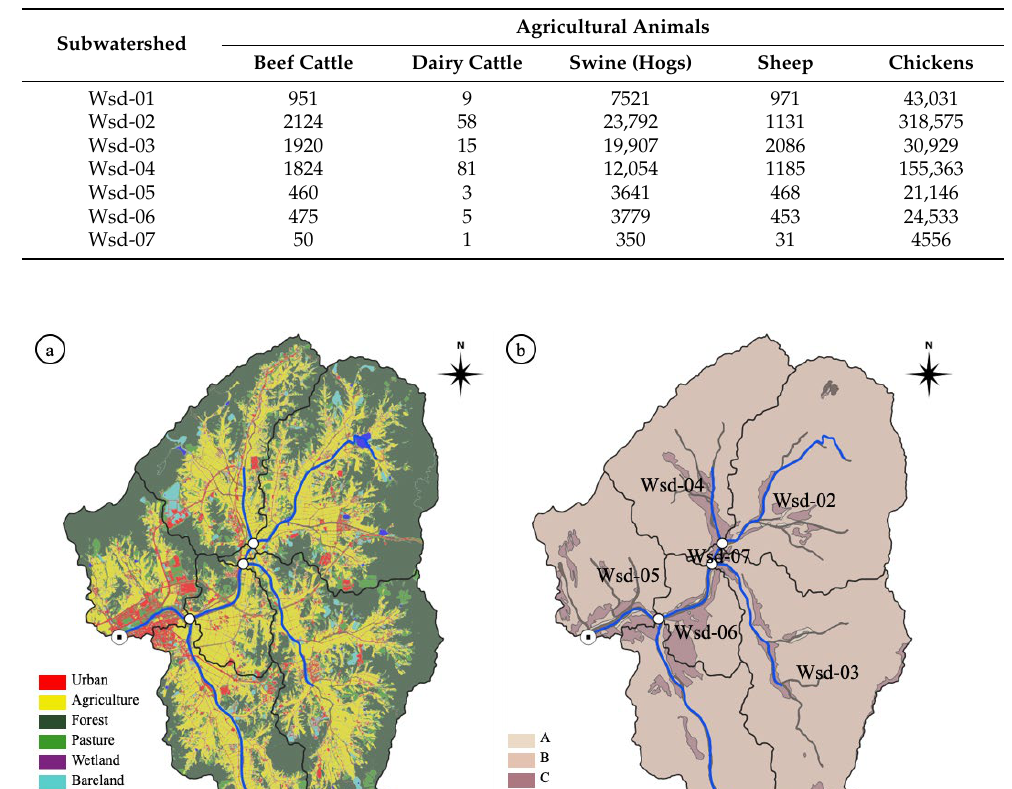
Table 2. Number of agricultural animals in subwatersheds where model was applied.